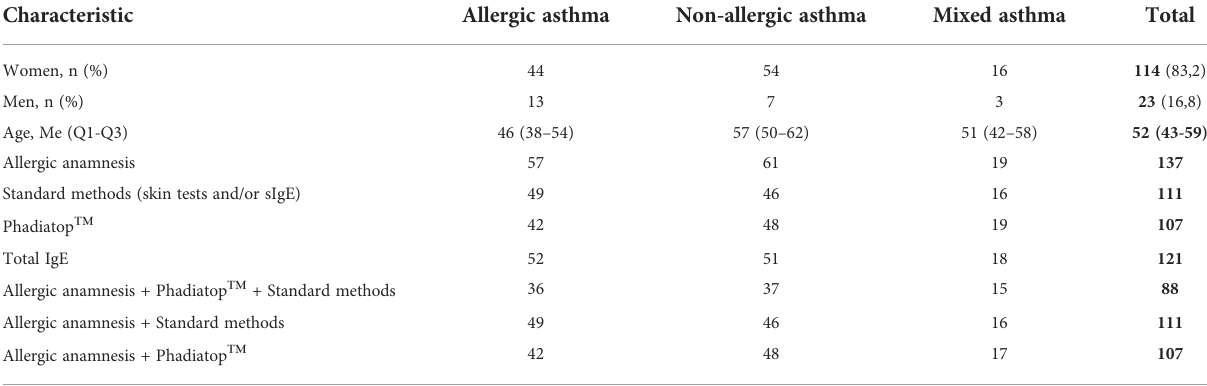
TABLE 1 Characteristics of the patients and examination